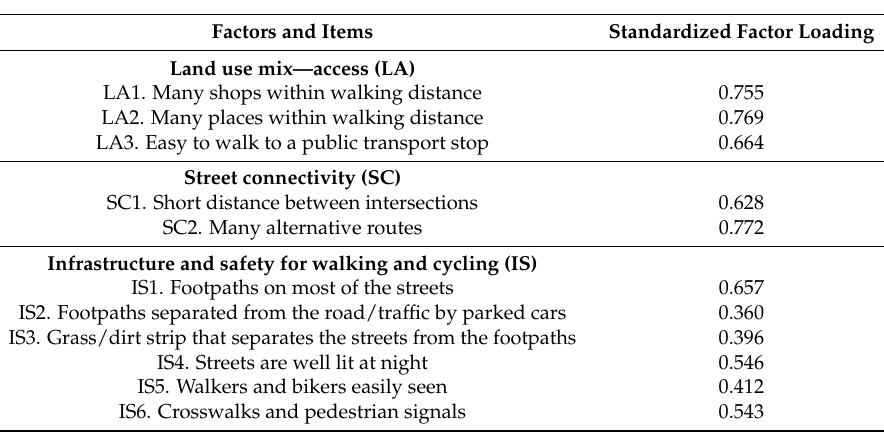
Table 1. Standardized factor loadings of the